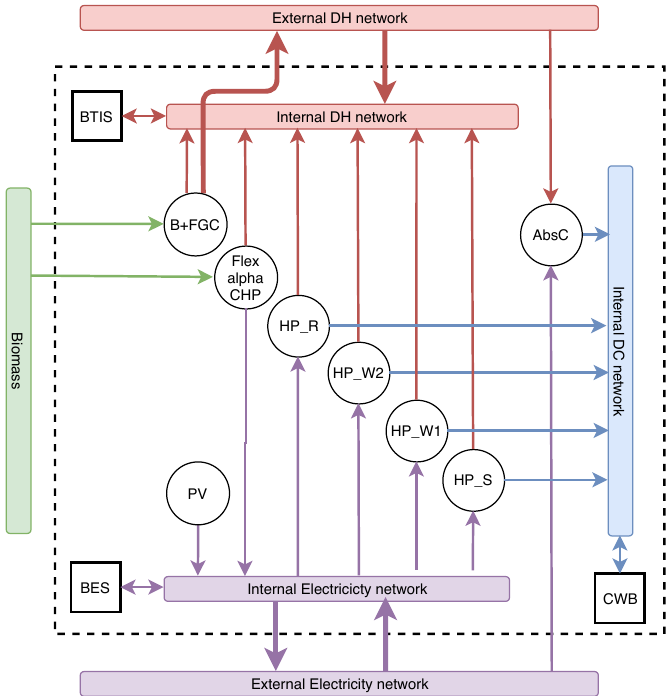
Figure 2. Campus’ energy system structure. HP R , HP S , and HP W1,2 are the four heat pumps. AbsC is the absorption chiller, and B+FGC represents the biomass boiler (B) with a flue gas condenser (FGC). BITES is the thermal energy storage in the buildings’ inertia, CWB is cold water basin storage, and BES is the battery energy storage.